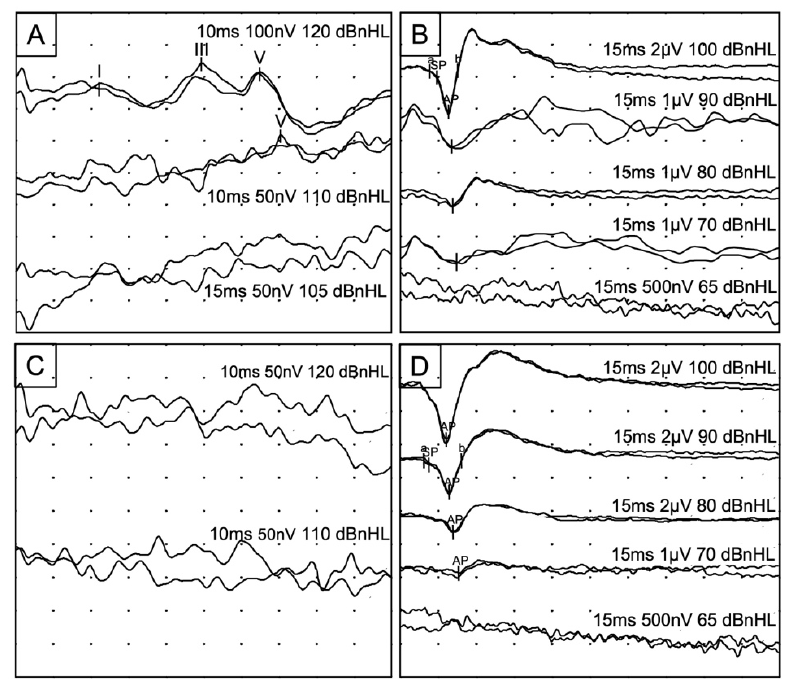
Figure 2. ABR and RW-ECOG thresholds in a 5-month-old child. ( A ) ABR threshold in the right ear set at 110 dB nHL. ( B ) RW-ECOG threshold in the same ear observed at 70 dB nHL. ( C ) ABR in the left ear does not allow observation of the hearing threshold. ( D ) RW-ECOG threshold in the same ear at 70 dB nHL.